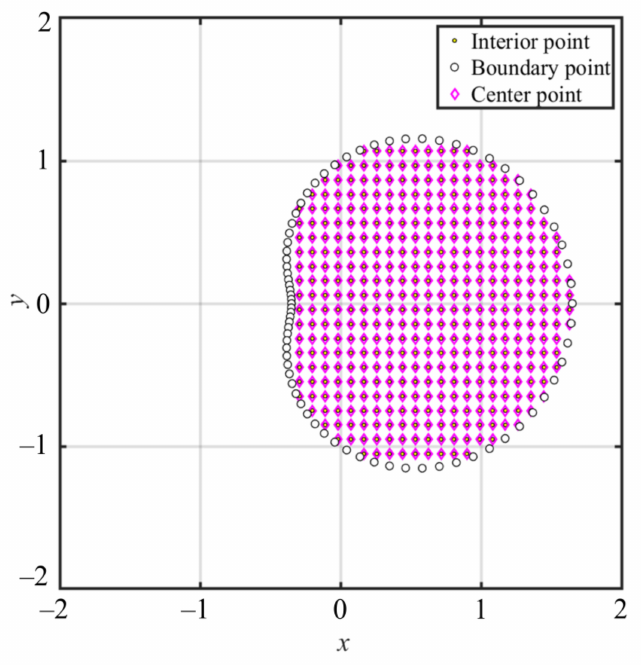
Figure 5. The conventional radial basis function collocation method (RBFCM) collocation scheme.